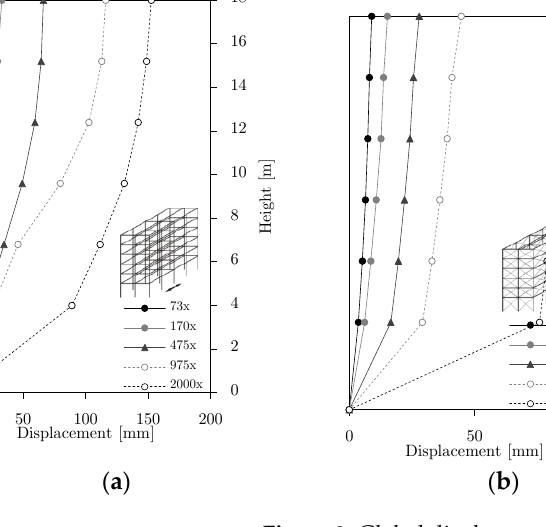
Figure 2. Global displacements for different seismic demands for RC ( a ) Bare-frame and ( b ) Infilled frame (adapted from Ref. [3]), and ( c ) Local demands’ influence on infill wall on the RC columns.